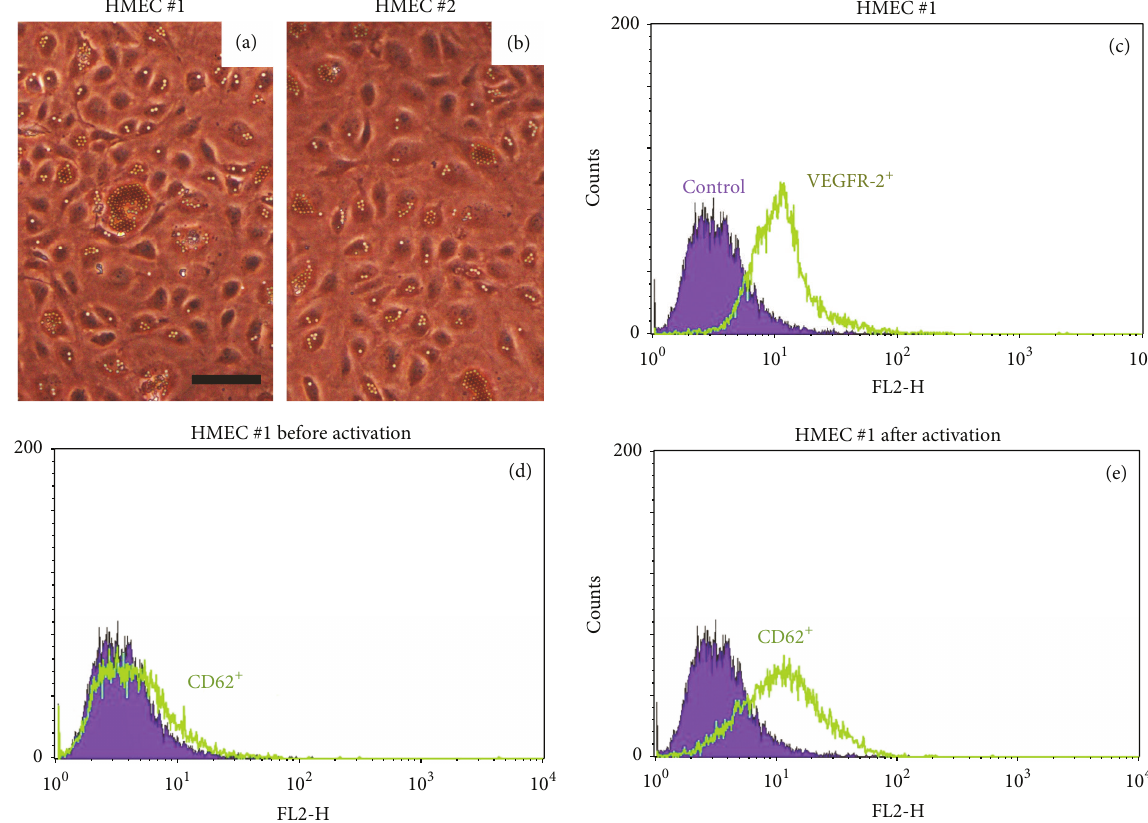
Figure 1: Primary HMEC cultures. A representative HMEC primary culture from donor 1 (a) and donor 2 (b). Images were obtained using a Lei c1 DM5000B microscope (scale bar, 50 𝜇 m). Flow cytometric analysis of HMEC from donor 1 before activation (c, d) and after